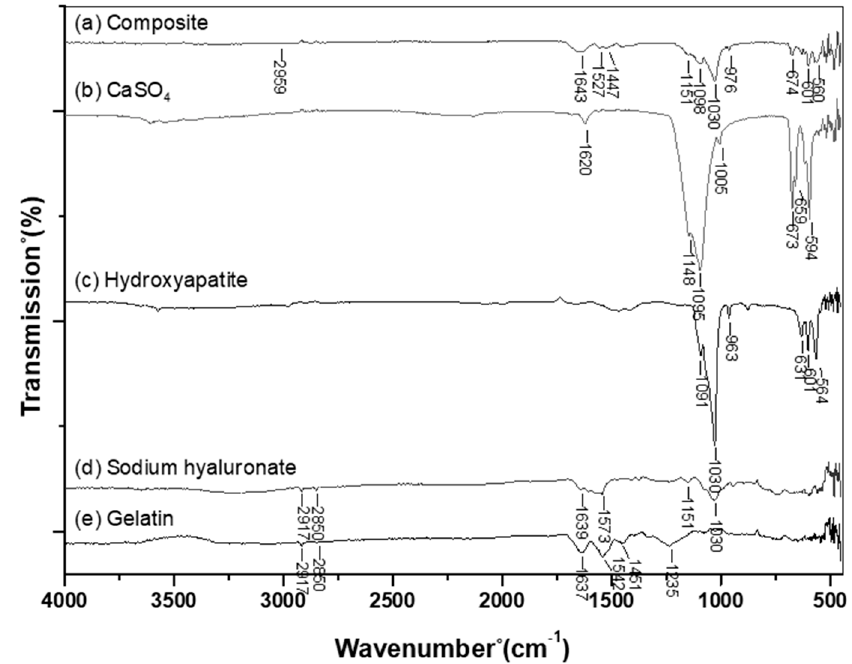
Figure 2. Fourier-transform infrared spectroscopy (FTIR) spectrum: ( a ) Gel-HA / CS / HAP composite, ( b ) calcium sulfate, ( c ) hydroxyapatite, ( d ) sodium hyaluronate, and ( e ) gelatin. The absorbance band at 2959 cm − 1 was the C–H bonding stretching of 1,4-butanediol diglycidyl ether (BDDE), indicating that the gelatin and hyaluronic acid in the composite of this study were successfully crosslinked.